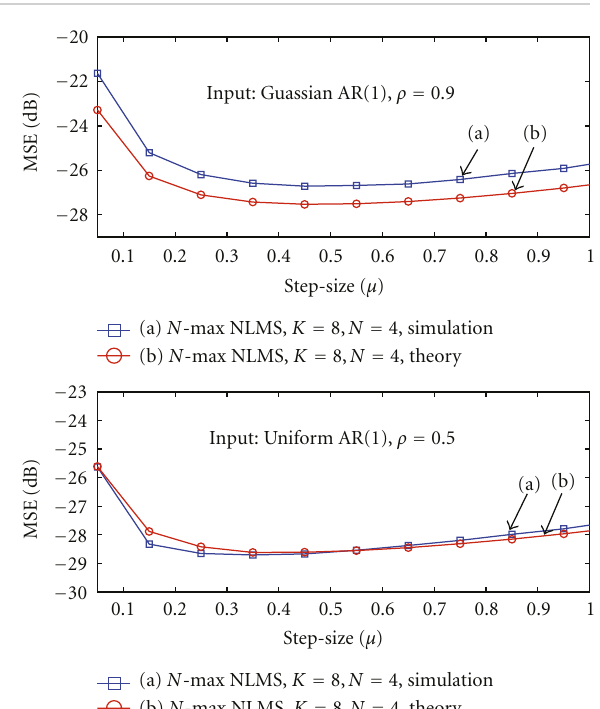
Figure 2: Steady-state MSE of N -Max NLMS with M = 8 and N = 4 as a function of the step size in nonstationary environment for di ff erent input signals.